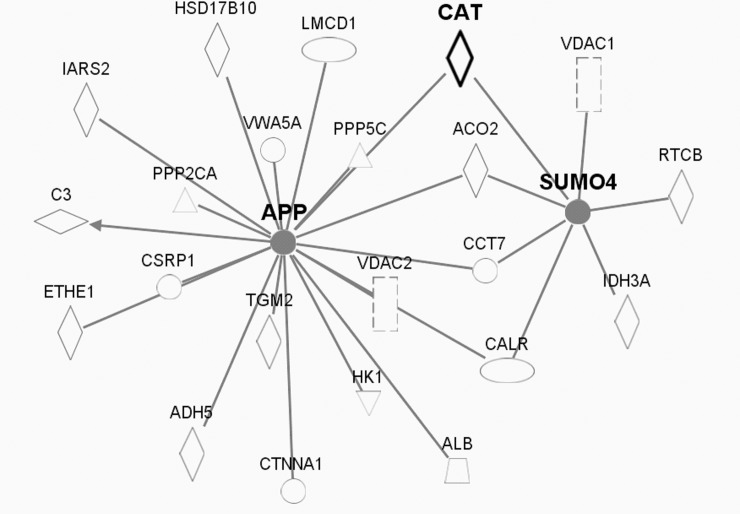
Pathway analysis-predicted protein networks associated with amyloid precursor protein (APP) and small ubiquitin-like modifier SUMO4.Legend to network analysis: enzyme (diamond), transmembrane receptor (vertical oval), transcriptional regulator (horizontal oval), phosphatase (triangle), transporter (trapezoid), kinase(triangle), growth factor (square), and other (circle). Relationships: interaction (—), activation (arrow).